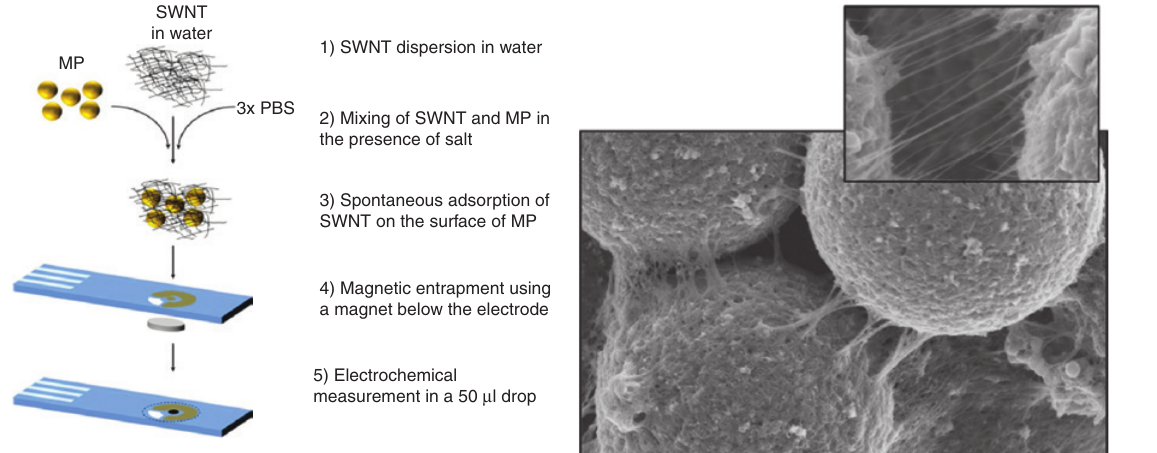
Figure 7: Electrode modification by CNT magnetic coentrapment. Scheme of the procedure for the production of a MP-CNT magnetic nanocomposite and its subsequent confinement onto the surface of a working electrode. The SEM image on the right shows how CNT form a web that connects the MP between them and with the electrode surface. This strategy has been successfully applied for the reversible nanostructuration of C-SPE and also for the enhanced electrochemical biosensing of the MP